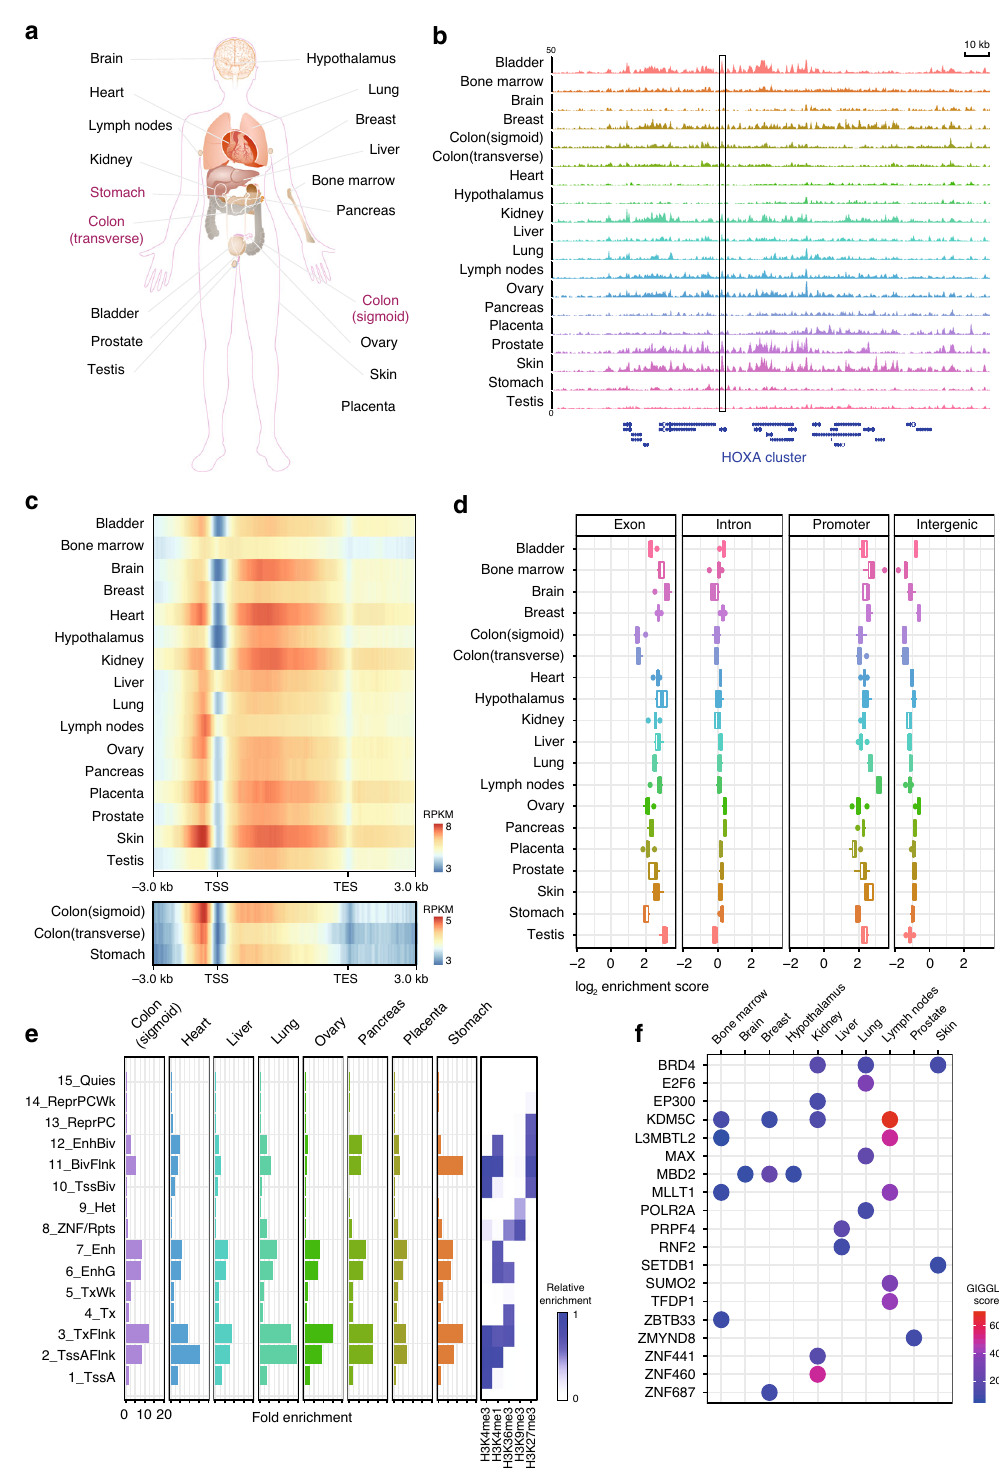
Fig. 1 Landscape of 5hmC across different tissues. a Schematic plot showing all the organ tissues analyzed in this study. Tumor adjacent tissues are marked in red. b Genome Browser view depicting 5hmC genomic distributions at the HOXA gene cluster for one representative donor ’ s pro fi le for each of the 19 tissue types assayed. The peak outlined with a box shows a highly variable region as an example. c Metagene plot of 5hmC pro fi les across different tissues showing underrepresentation of 5hmC at TSS regions and over-representation at gene bodies and promoters. The color ranges indicate RPKM values. Upper panel, normal tissues; lower panel, tumor adjacent tissues. TSS, transcription start site. TES, transcription end site. d Boxplots showing genomic enrichment of 5hmC peaks at RefSeq exons, introns, promoters, and intergenic regions. N = 5 biologically independent samples were used ( n = 4 for hypothalamus and n = 6 for sigmoid and transverse colon). For all boxplots, center line represents median, bounds of box represent 25th and 75th percentiles and whiskers are Tukey whiskers. e Enrichment of 5hmC peaks on 15 chromHMM chromatin states from the Roadmap Epigenomics Project for 8 tissue types. Histone modi fi cation emissions data are directly from the Roadmap Epigenomics Project. f Enrichment of trans-acting factors binding sites on 5hmC peaks in different tissues. Higher GIGGLE score means higher possibility of